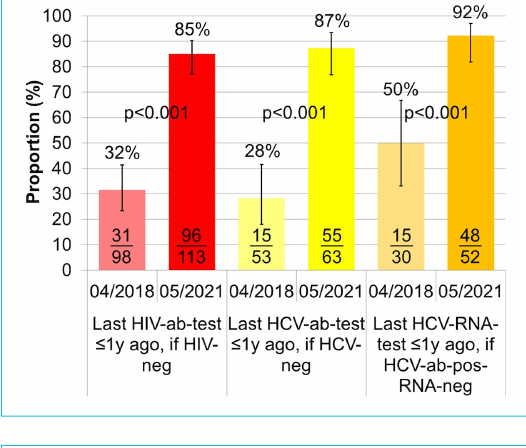
Figure 4: HCV treatment uptake and HCV RNA prevalence (n = 200).HCV: hepatitis C virus; CHC: chronic hepatitis C; ab: anti- body; RNA: ribonucleic acid; HCV treatment uptake: proportion of CHC patients ever treated; HCV RNA prevalence: proportion of HCV antibody positive patients with known HCV RNA that are HCV RNA positiveThe error bars show the lower and upper limit of the 95% confidence interval (Score